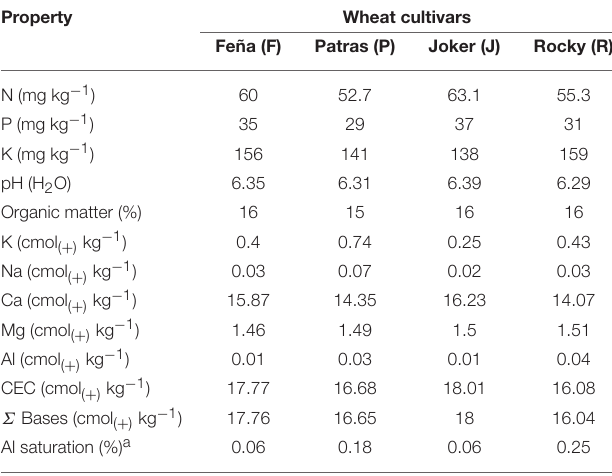
TABLE 1 | Chemical properties of rhizosphere soils used in this study. Property Wheat cultivars